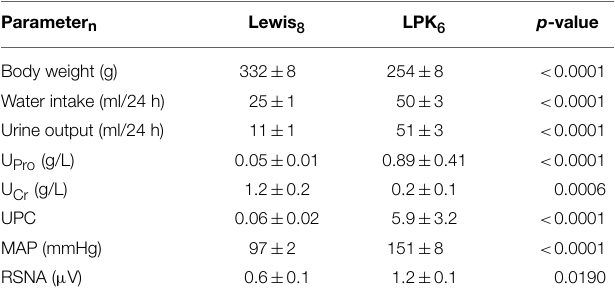
TABLE 1 | Phenotypic characteristics of Lewis and LPK